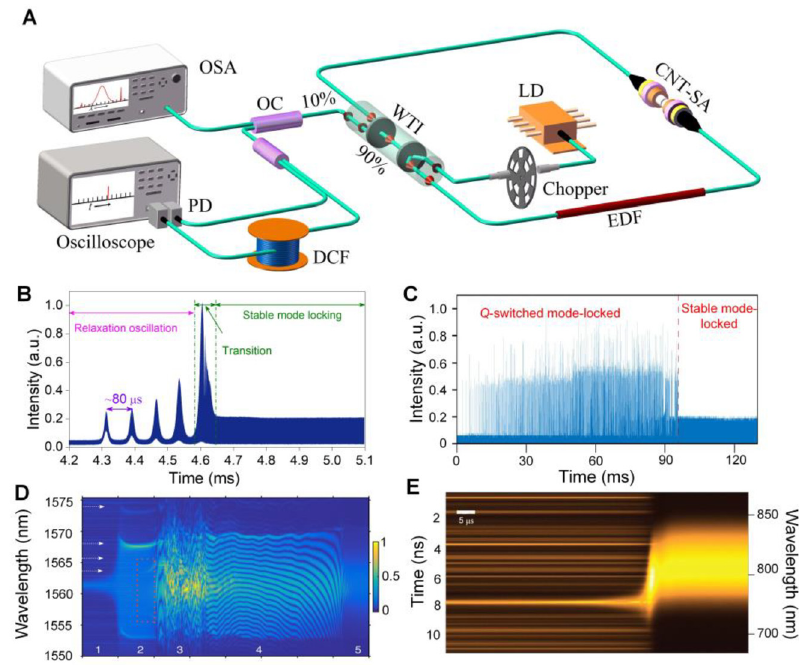
Figure 10: Experimental real-time measure- ment of the buildup dynamics of